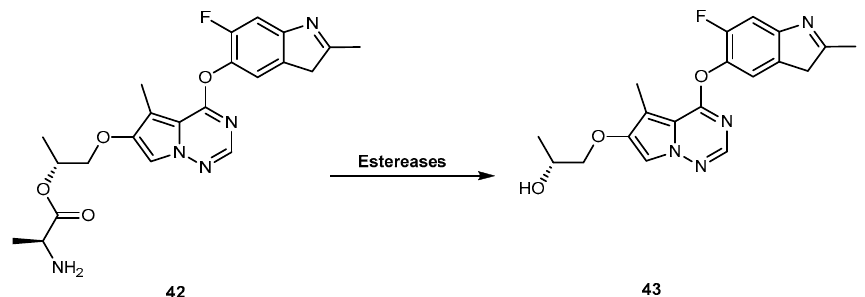
Molecules 2018 , 23 , x FOR PEER REVIEW 20 of 60 Figure 20. Bioconversion of brivanib alaninate ( 42 ) to brivanib ( 43 ) by esterases.